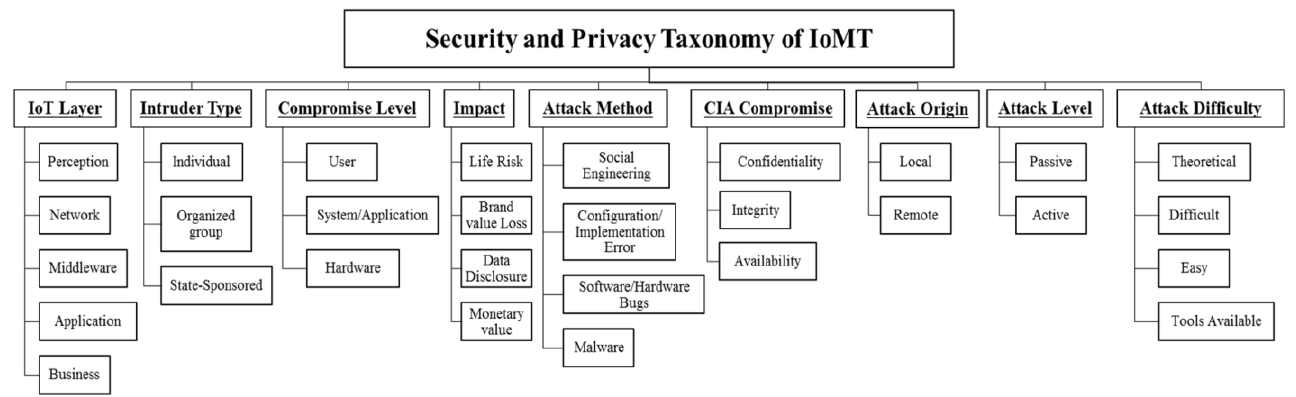
Figure 31. Security and privacy taxonomy of IoMT [33]. Abbreviations used: IoMT, Internet of Medical Things; IoT, Internet of Things; and CIA, Confidentiality, Integrity, and Availability. Reprinted with permission from ref. [33]. 2017 Institute of Electrical and Electronics Engineers.